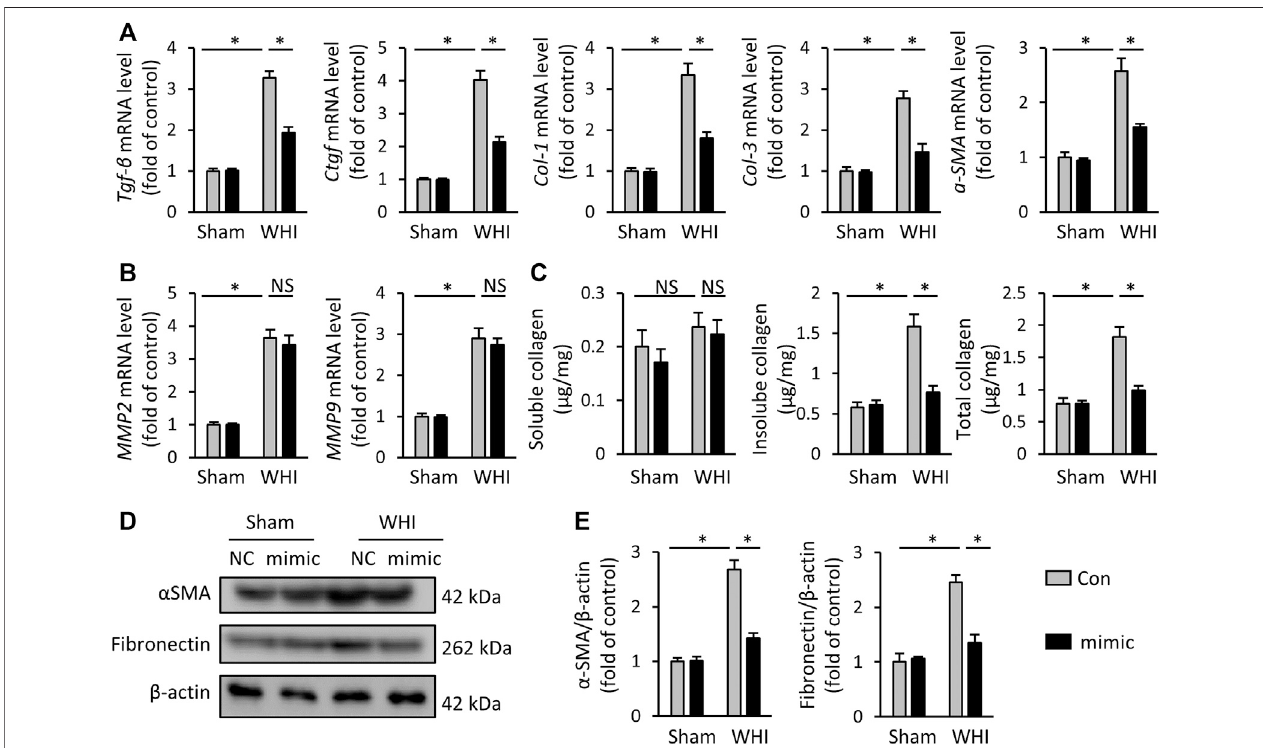
FIGURE 3 | miR-223-3p mimic reduces myocardial fi brosis in RIHD mice. (A) Relative mRNA levels of Tgf- β , Ctgf , Col-1 , Col-3 , and α -SMA in the hearts ( n (cid:2) 6). (B) Relative mRNA levels of MMP2 and MMP9 in each group ( n (cid:2) 6). (C) Total, soluble, and insoluble collagen content were assessed in each group ( n (cid:2) 6). (D , E) Relative protein expression of α -SMA and fi bronectin in each group ( n (cid:2) 6). All data are presented as means ± SD. * p < 0.05 vs. the matched group.